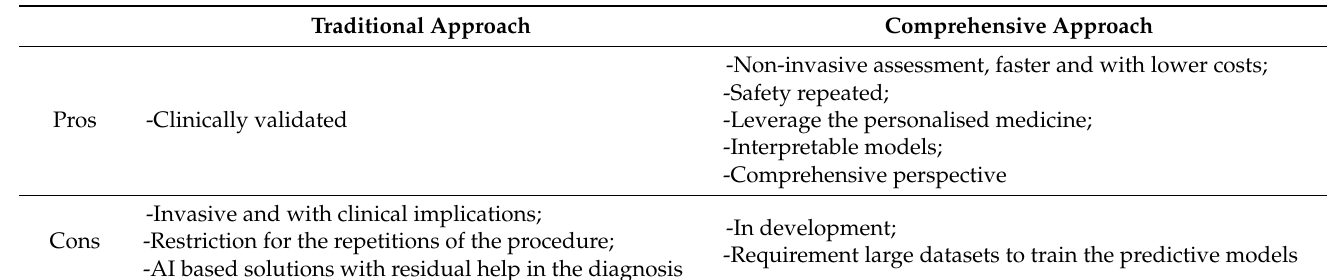
Table 1. Pros and Cons of traditional and comprehensive approaches for lung cancer diagnosis. Traditional